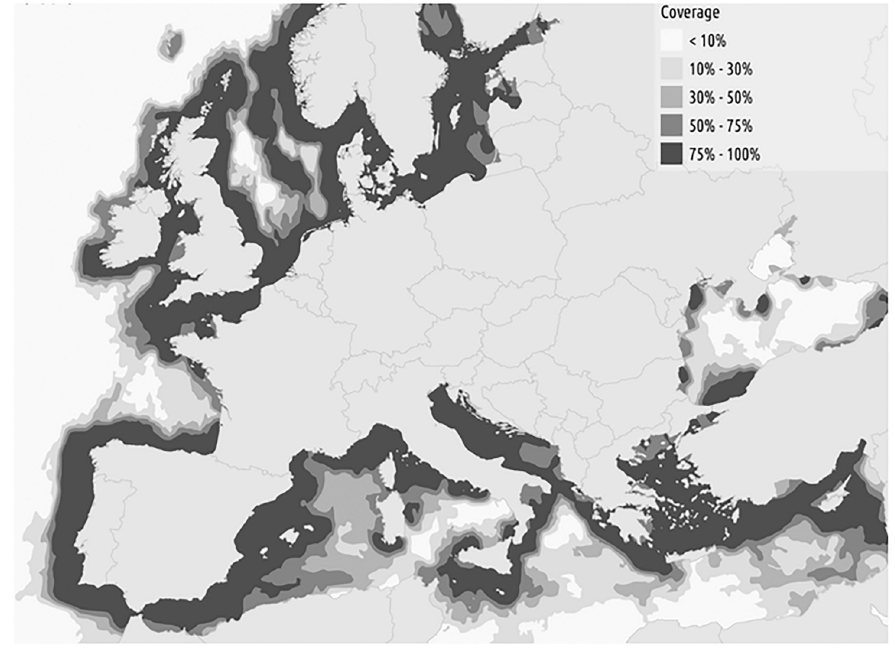
Fig 1. Assessment of the AIS data coverage. The map displays the median of normalised values after the assessment of coverage was performed